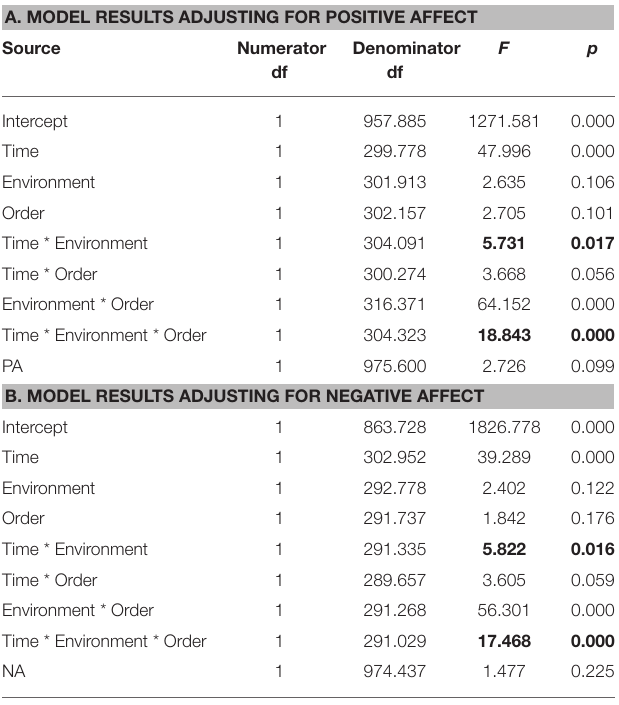
TABLE 7 | Effects † of time (pre, post) × environment (nature, urban) × order (nature 1st, urban 1st) effects on BDS, adjusting for Positive Affect vs. Negative Affect, for study samples with environment as a within-subjects factor.